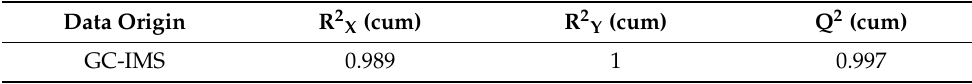
Table 4. The VIP values for differential volatile flavor substances between LSCK and HSCK.